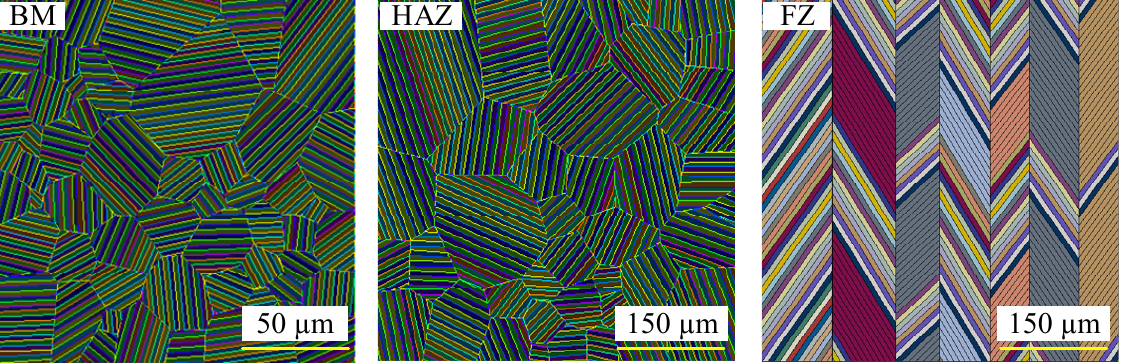
Figure 6. Microscopic grain model of different areas of weld toe.